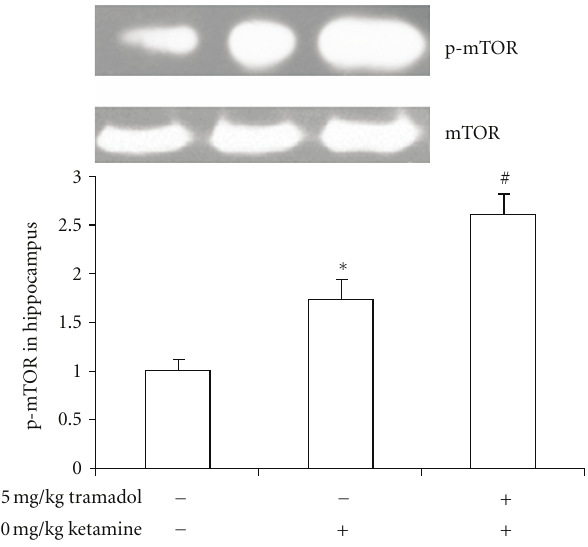
Figure 4: The expression of p-mTOR in rat hippocampus ( n = 3). Ketamine administered at the 10 mg/kg significantly increased the expression of p-mTOR in rat hippocampus as compared with control ( ∗ P < 0 . 05), and tramadol pretreated at the dose of 5mg/kg significantly increased the expression of p-mTOR as compared with ketamine administered alone ( # P < 0 . 05).